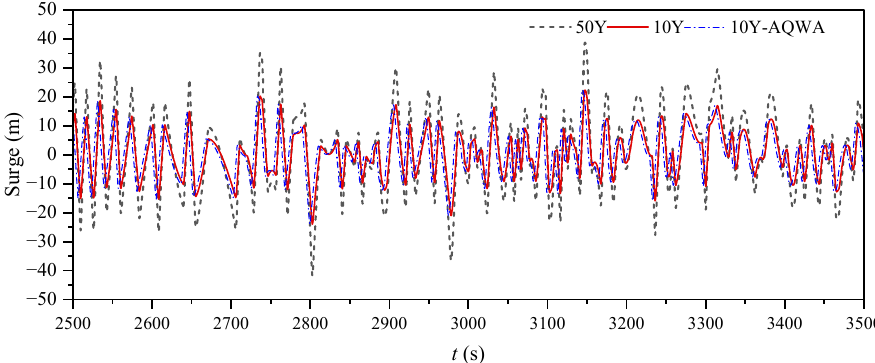
Figure 8. Surge motion of TLP under different wave heights.